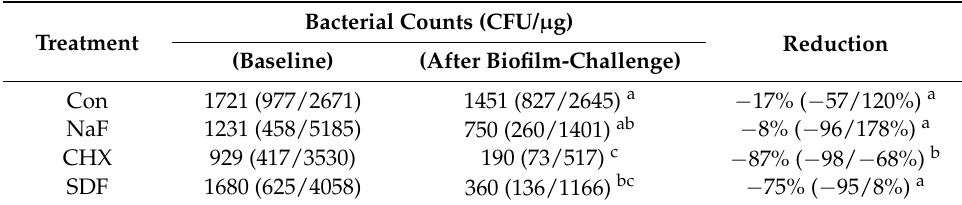
Table 1. Bacterial numbers in dentinal lesions (at baseline and after biofilm challenge) and bacterial reduction compared with baseline (before